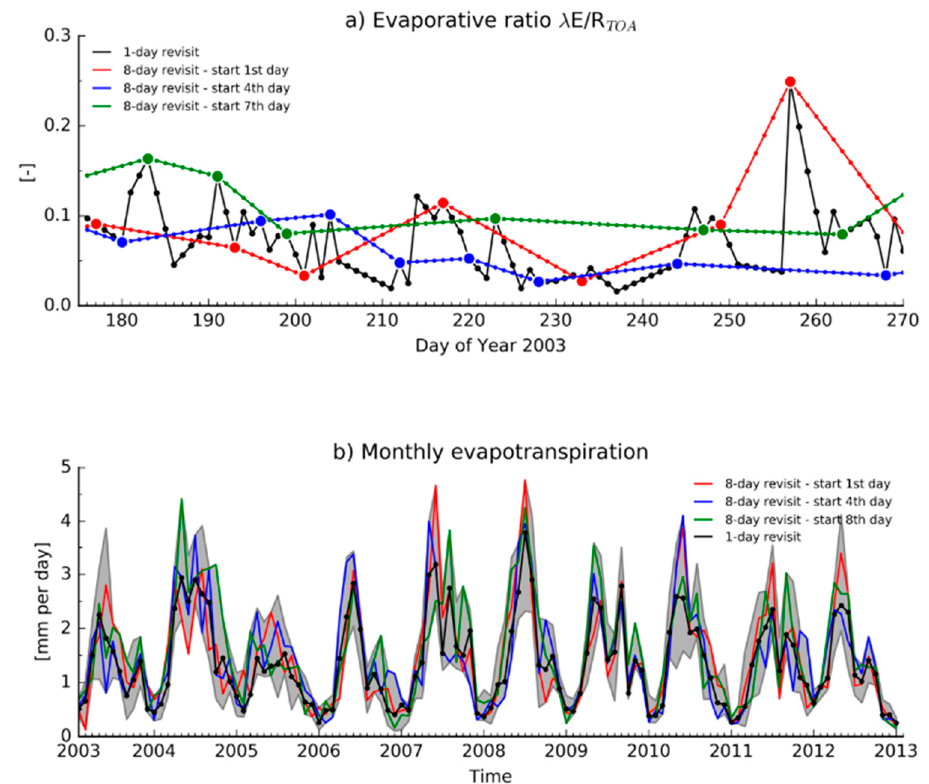
Figure 1. Methodology used to generate different revisit scenarios—the figure presents an example of an eight-day revisit scenario using data collected at the Atmospheric Radiation Measurement (ARM) Southern Great Plains, OK. ( a ) A control evaporative ratio series is calculated using ground-based measurements at a given satellite overpass time assuming a one-day revisit period—here the modeled top-of-atmosphere incoming shortwave radiation (R TOA ) is used as scaling reference flux. Eight different eight-day revisit scenarios can be derived from the control one-day series by starting each sample on a different day. For the eight-day scenarios, the larger markers in ( a ) represent clear sky observations, and the smaller markers represent days with no satellite observations (due to return period or clouds) associated with evaporative ratios estimated from two consecutive clear sky observations using linear interpolation. ( b ) Impact of different eight-day revisits initializations on monthly ET estimates. The gray filled area represents the ensemble of eight-day revisit samples associated with eight different start